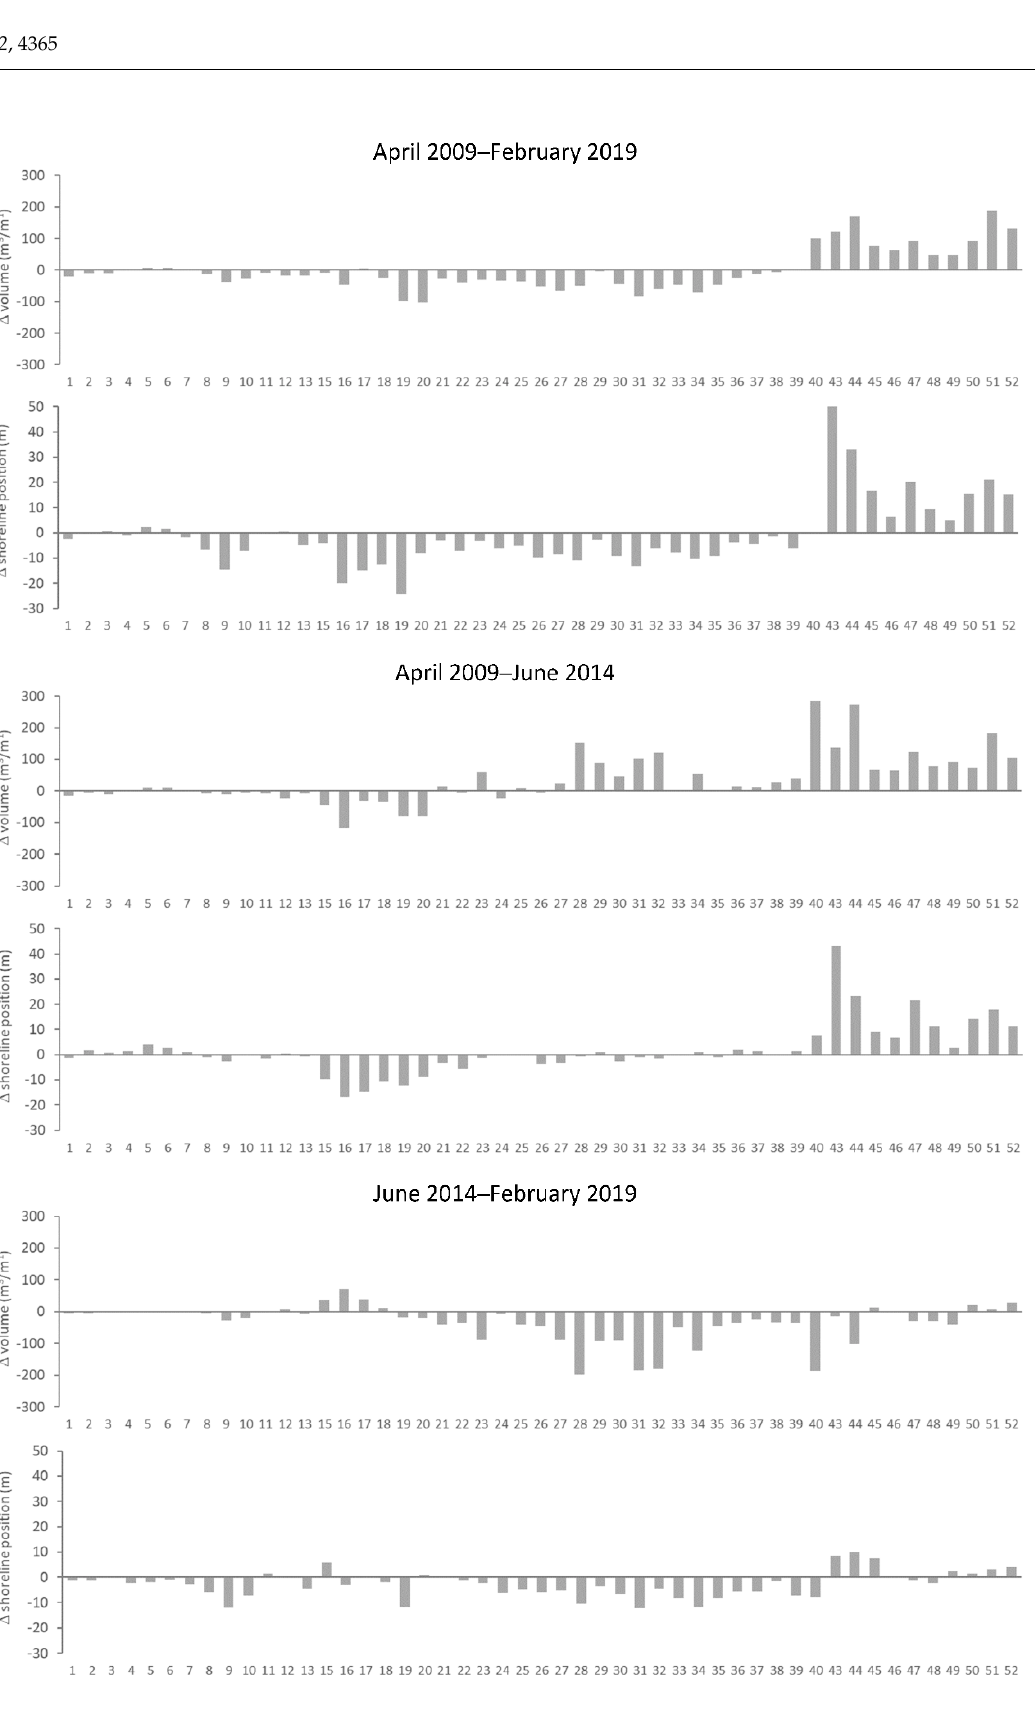
Figure 9. Decadal and 5-yearly changes in volume and shoreline position per segment, presented from north (segment 1) to south (segment 52); segment IDs are presented below the graphs; positive shoreline change values represent seaward migration and negative values represent landward migration.